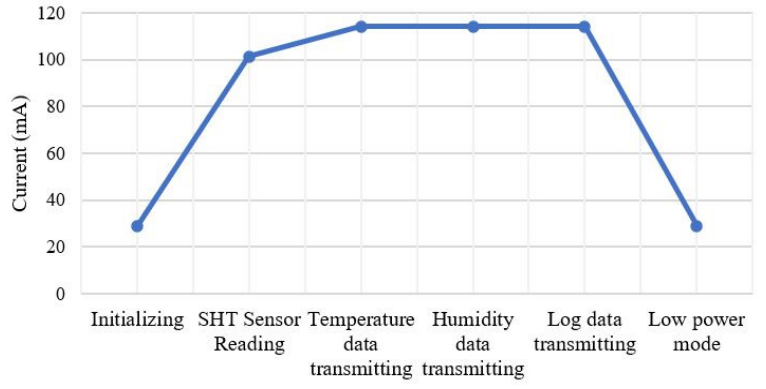
Figure 14. Current measurement result for one working cycle.